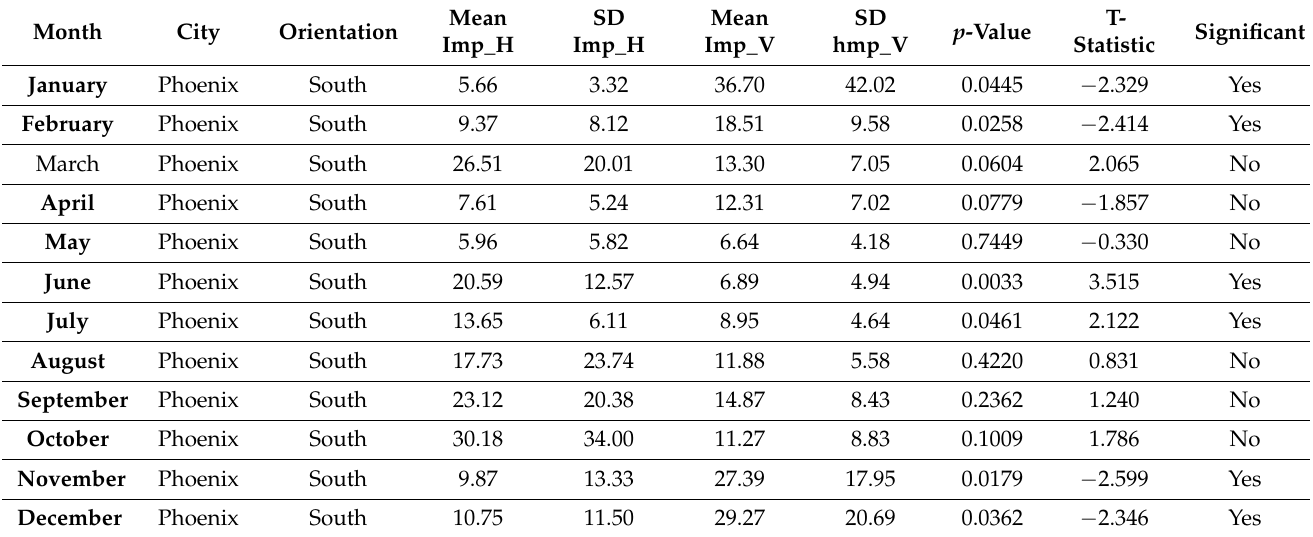
Table 14. Significant differences between horizontal and vertical louvers for the months of January,